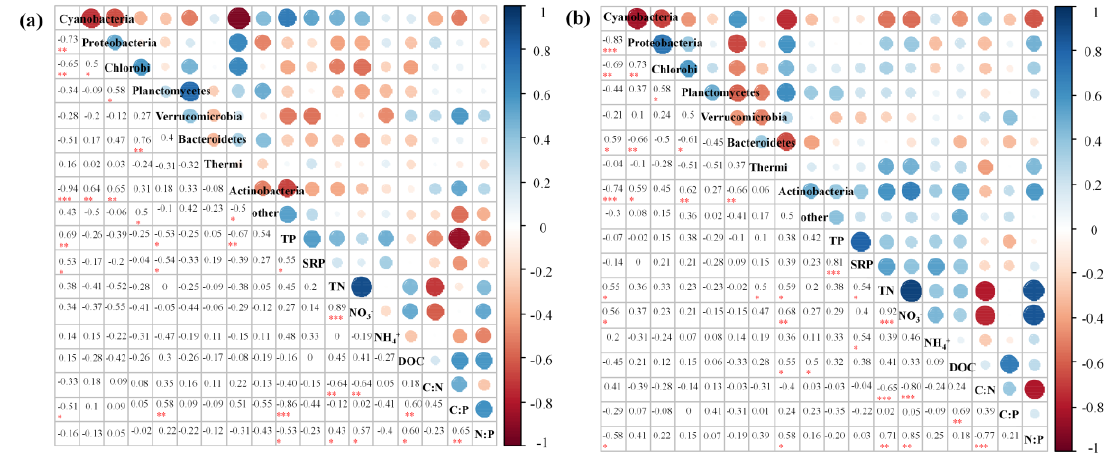
Figure 6. Spearman’s rank correlation between nutrients and microbes at the phyla-level in ( a ) Erhai Lake and ( b ) streams. Blue nodes indicate positive associations and red nodes negative associations. Nodes are sized and present the degree of correlations. *** indicates statistical significance at p < 0.001, ** indicates p < 0.01 and * indicates p < 0.05.